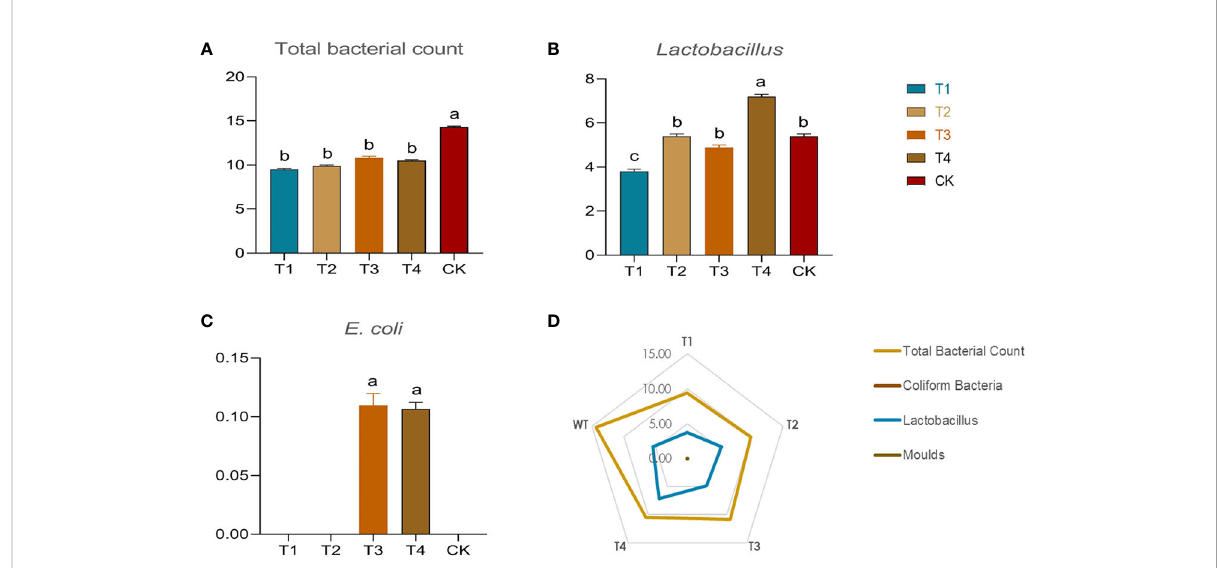
FIGURE 5 Bacterial counts and proportions in different drought treatments and controls. The graph includes (A) total bacterial counts, N*10 7 CFU/g; (B) lactobacillus counts, N*10 7 CFU/g; (C) E coli counts, N*10 7 MPN/g; (D) summary radar plots. The N in front indicates the number in the fi gure. The numbers in the graph indicate the speci fi c bacterial content of each